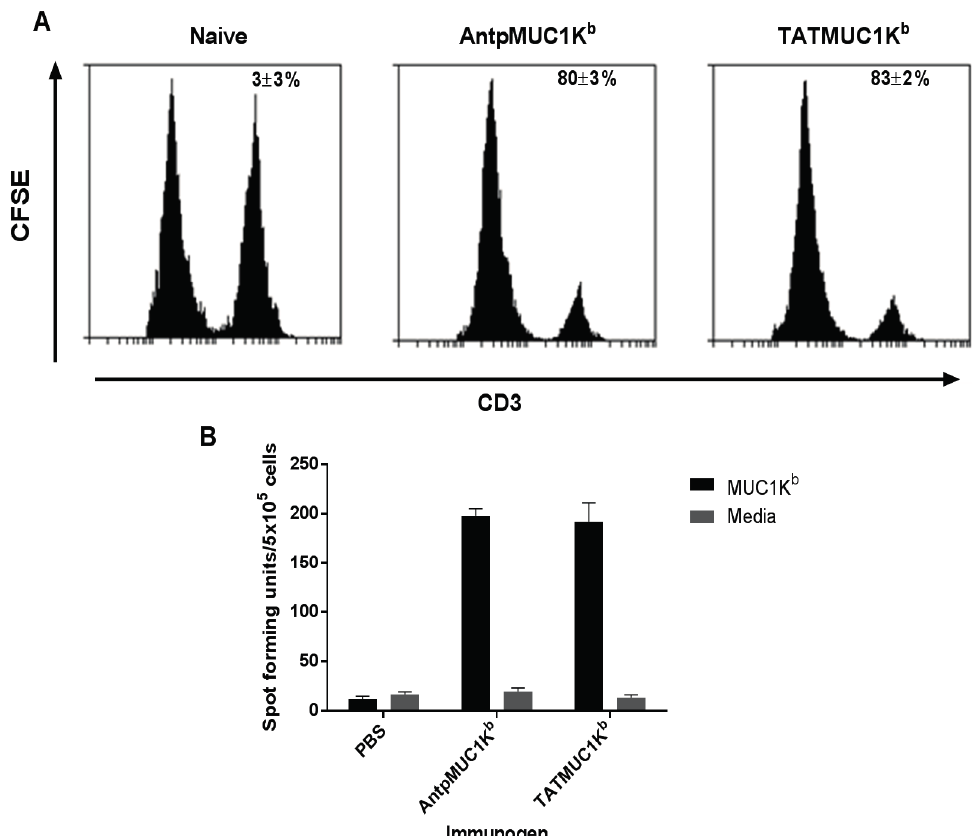
Figure 7. Cellular immune responses in TATMUC1K b and AntpMUC1K b immunised mice, measured as in vivo CTL killing and ELISpot assays. ( A ) C57BL/6 mice were immunised i.d. with PBS, 25 µg AntpMUC1K b or 25 µg TATMUC1K b and the percent